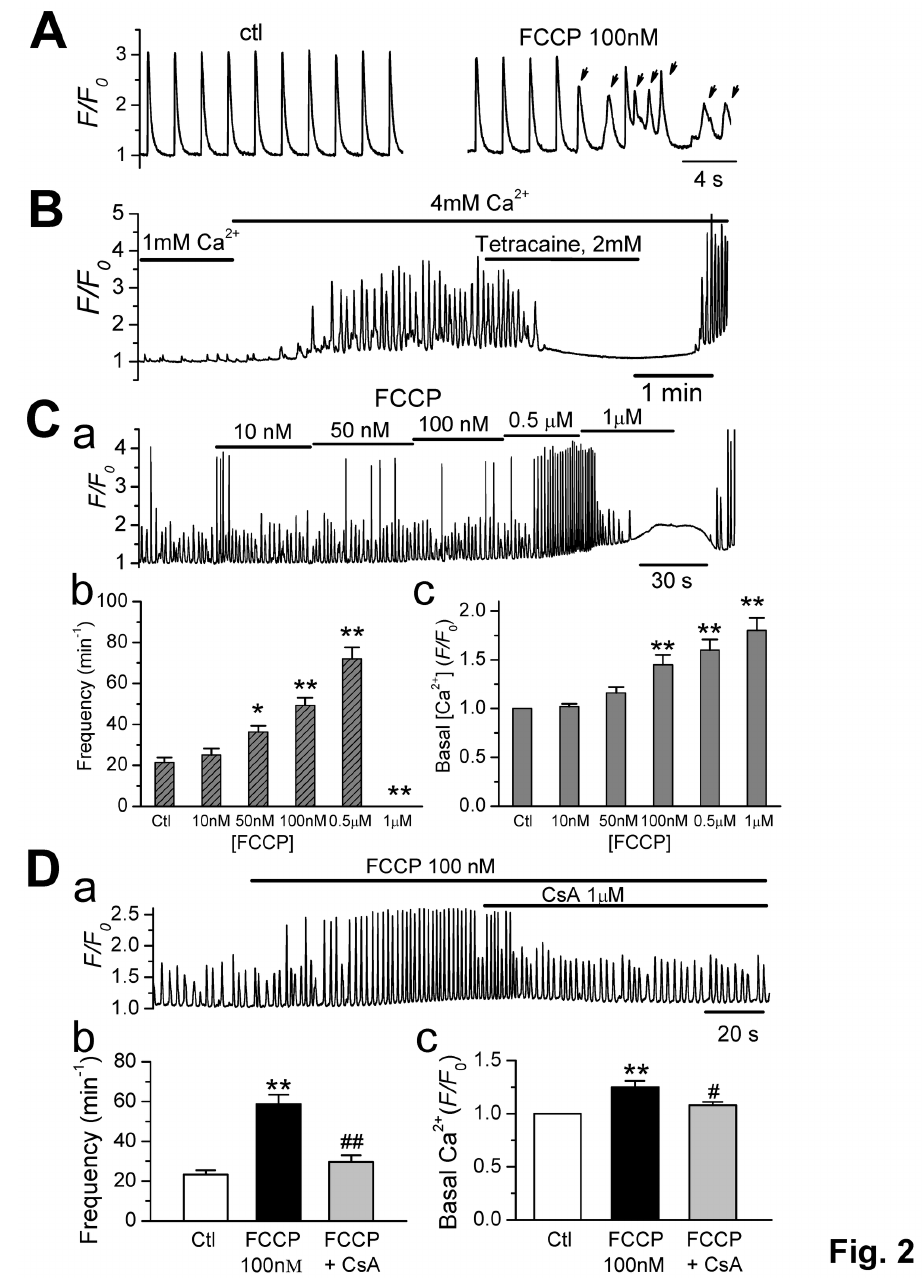
Figure 2. Effect of FCCP on High [Ca 2+ ] -induced Ca i2+ waves. A . FCCP (100nM) induced spontaneous CaWs (indicated by o arrows) under normal excitation contraction coupling (ECC). The cells were paced by field stimulation at 0.5 Hz in the presence of 1 mM Ca 2+ concentration under control (ctl) condition and ~ 5 min after perfusion with 100 nM FCCP. B . A Ca i2+ fluorescence trace recorded from a mouse ventricular myocytes. The cell was first perfused with the normal Tyrode's solution (1 mM Ca 2+ ) and then with a high Ca 2+ Tyrode's solution (4 mM Ca 2+ ). Ca i2+ waves (CaWs) were consistently observed in the presence of high external Ca 2+ (Ca o2+ ; 4 mM). Spontaneous Ca 2+ CaW were eliminated by Tetracaine (2 mM). C - a . A representative Ca i2+ fluorescence trace showing the dose-dependent effects of FCCP on the SCWs. C - b . Effect of FCCP on CaW frequency in a dose-dependent and biphasic manner. C - c . Summary data showing the effect of FCCP on basal Ca i2+ . ∗ p < 0.05, ∗∗ p < 0.01 vs. control (n = 6). D . Cyclosporin A (CsA), a mPTP inhibitor, significantly counteracted the effects of FCCP (100nM) on SCWs. A representative trace ( D - a ) and summarized data for CaW frequency ( D - b ) and basal [Ca i2+ ] level ( D - c ) are shown. ** p < 0.01 vs. Control; # P <0.05, ## p <